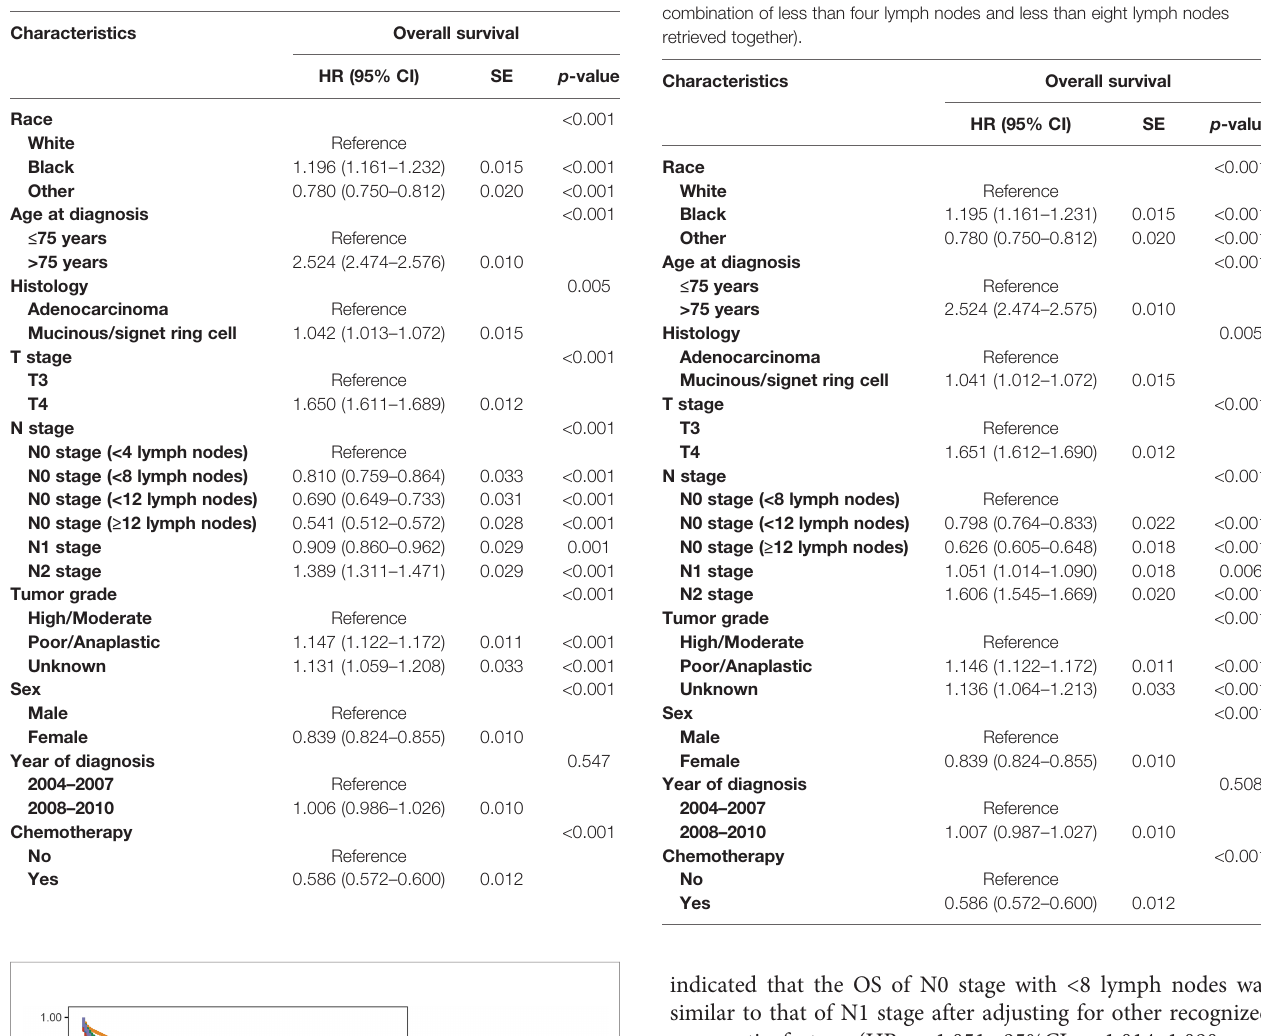
TABLE 2 | Multivariate analyses on overall survival in colon cancer.